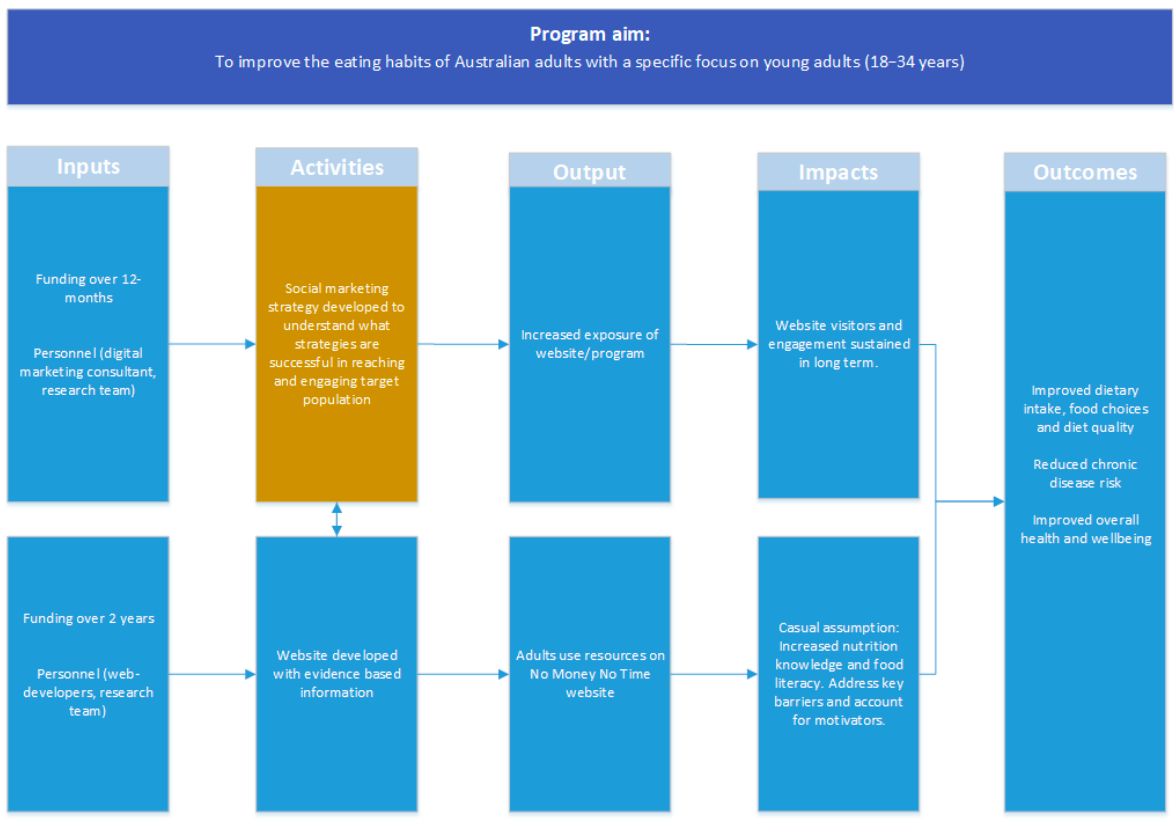
Figure 1. Logic model for the NMNT illustrating the role of the social marketing strategy. The site